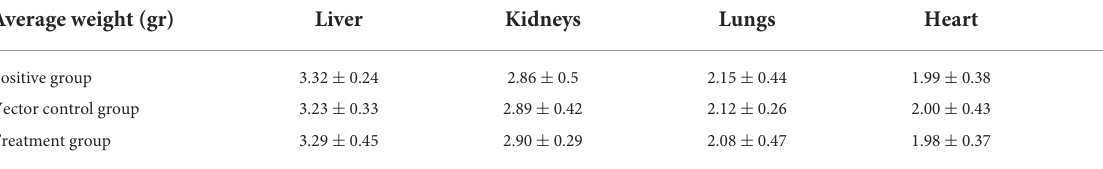
TABLE 1 Mean ± SD of tissue